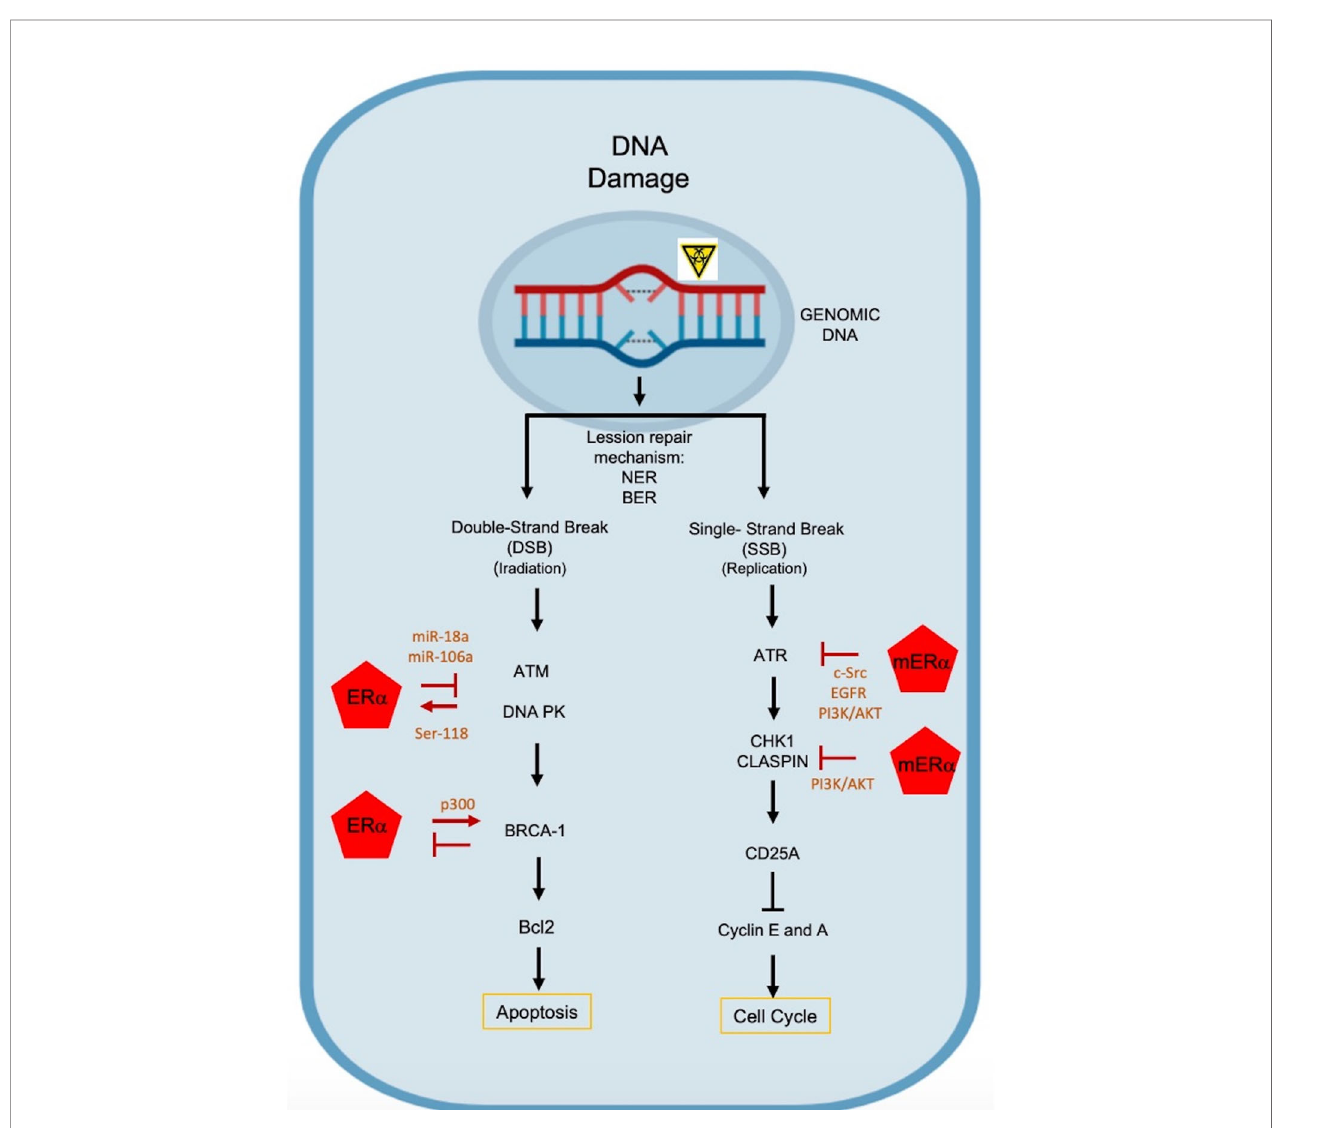
FIGURE 2 | Molecular mechanisms by which estrogens mediate chemoresistance. DNA alterations induce responses to DNA damage (DDR), activating different DNA repair mechanisms: NER, nucleotide excision repair; BER, base excision repair. DNA double-stranded breaks activate ATM and PK DNA effector kinases. ATM is repressed by ER through miR-18a and miR106a, and PK DNA phosphorylates ER a in the 118Ser residue, improving its transcriptional activation and preventing its degradation via proteasome. BRCA-1 represses ER a activity and ER regulates BRCA1 transcriptionally. Single-stranded DNA breaks activate the ATR kinase, which is blocked by non-genomic mRE a signaling that activates the PI3K/AKT pathway through c-Src kinase and EGFR. On the other hand, CHK1 and CLASPIN are repressed, inducing the activation of the PI3K/AKT